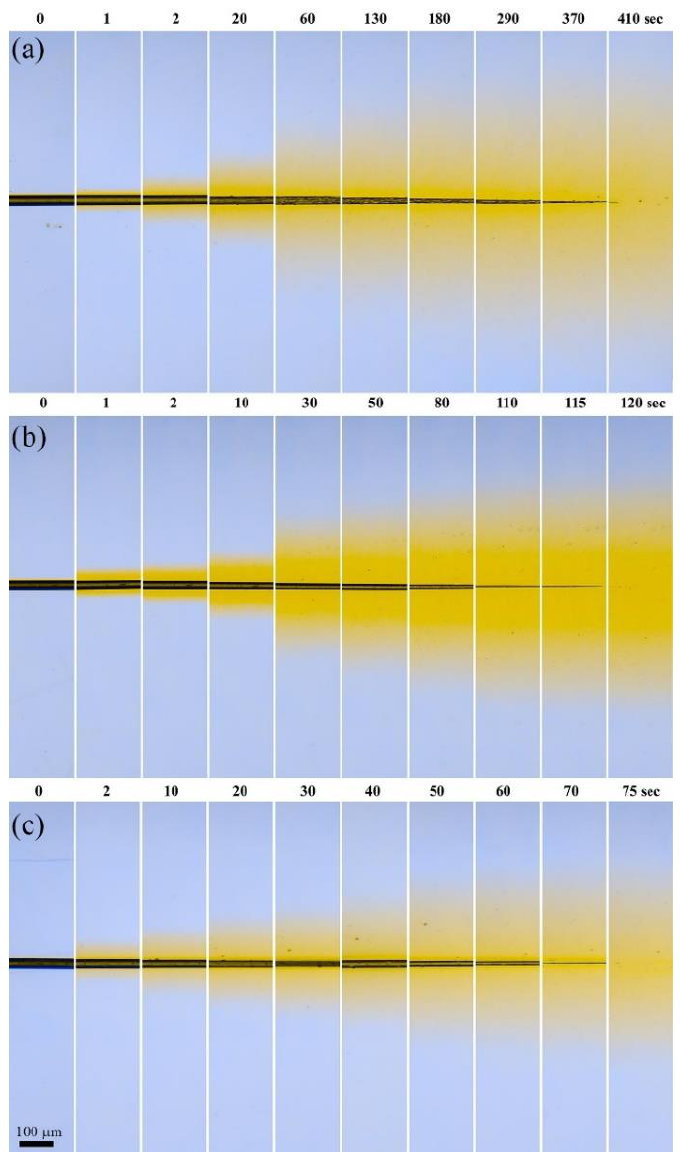
Figure 4. ABPBI fiber dissolution stages in a DMSO:MeOH:KOH complex solvent at DMSO:MeOH ratio: 9:1 ( a ); 7:3 ( b ); 4:6 ( c ).